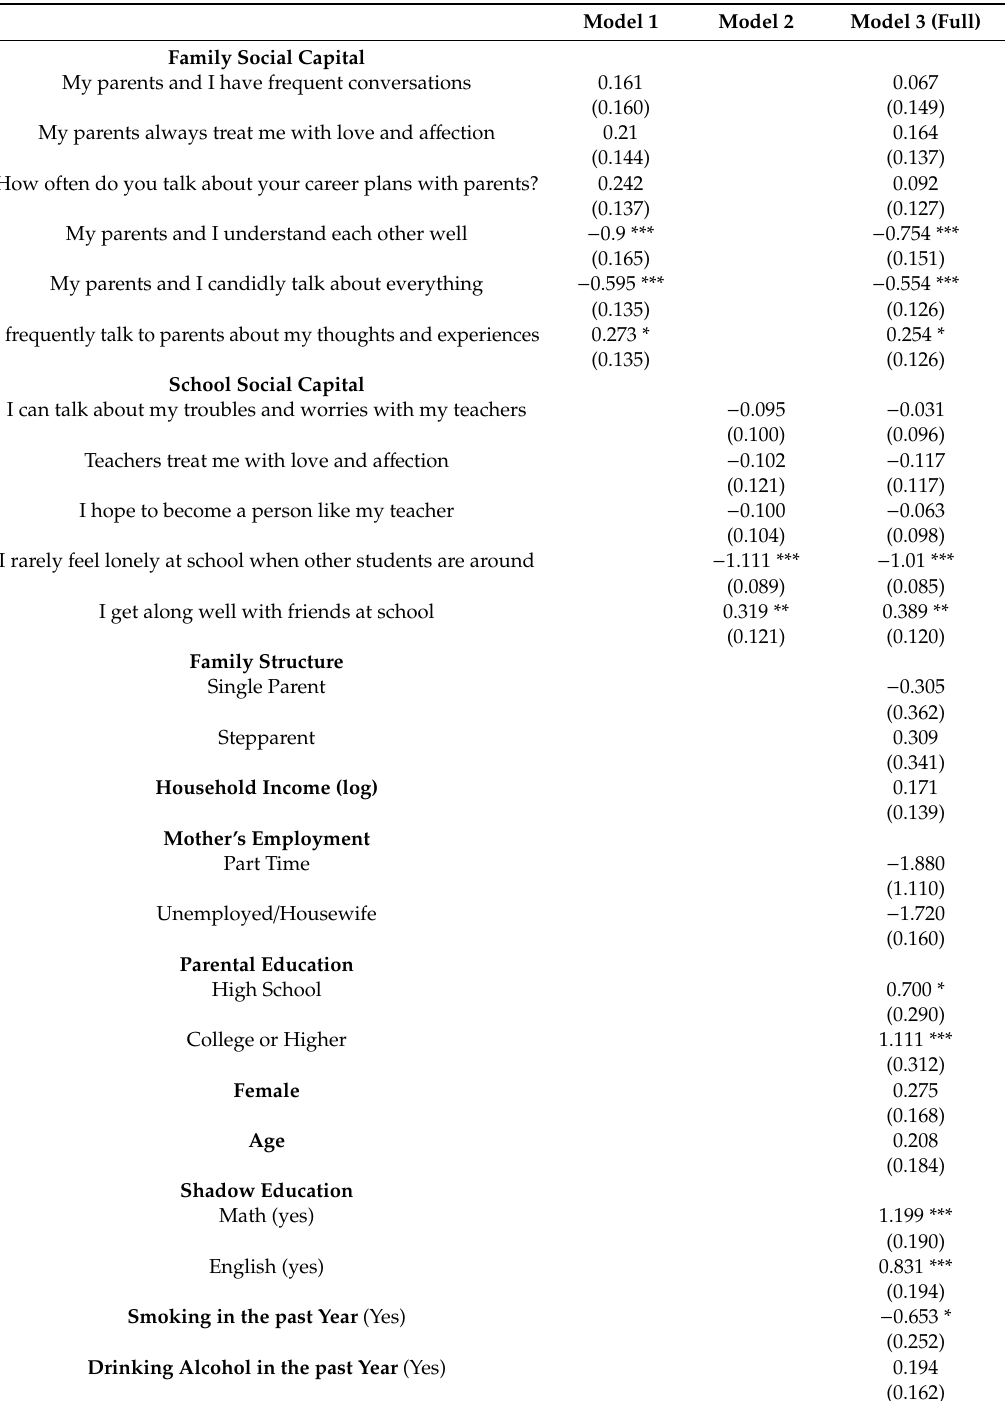
Table 2. OLS Regression Predicting Academic Stress by Family and School Social Capital, Individual and Household Characteristics: KYPS, Wave 5, 2008 ( N =